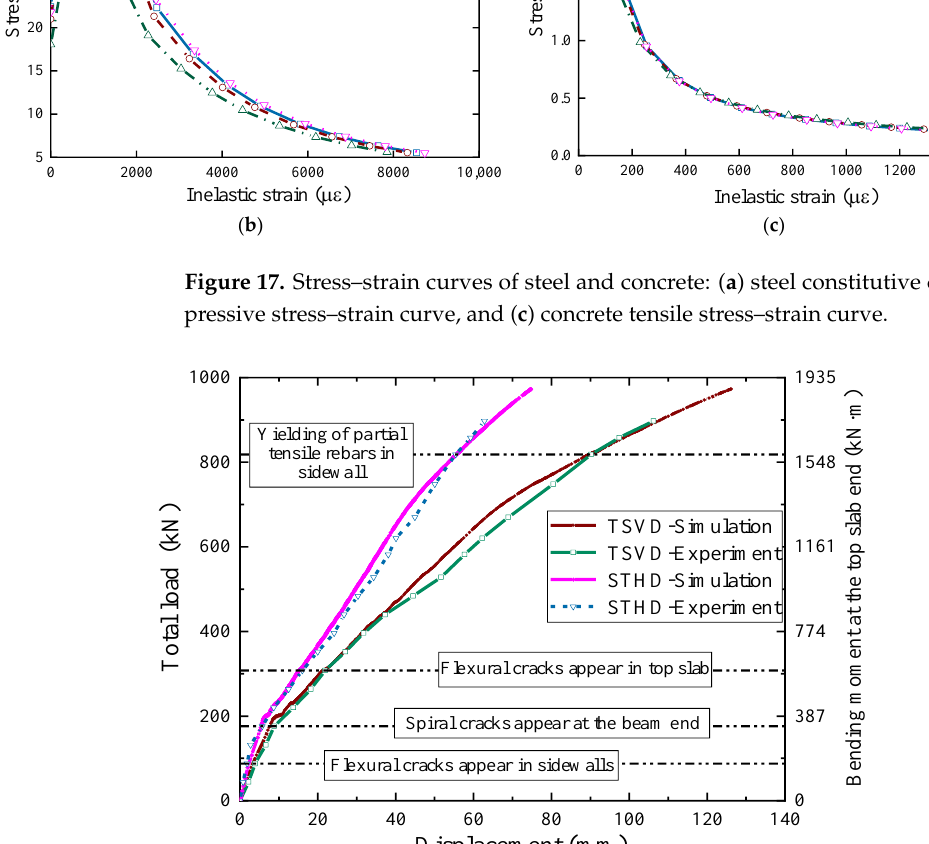
Figure 19. Maximum principal inelastic strain patterns from FE analysis. 4.3. Parametric Study A parametric study was conducted using the validated FE model to further investi- gate the effects of the entrance frame with different configurations on the development of cracks around the opening. The parameters were the steel ratio of the SRC frame and cross-sectional height of the column and beam. Table 3 summarizes the details of all cases in this parametric study. For convenience, these cases are denoted as E-X. Case E-1 em- ployed a validated FE model with a configuration similar to that of the test specimen, which could be treated as the baseline configuration for the other cases. Compared to E- 1, the steel ratio of the SRC beam in E-2 was zero, and that of the SRC column in E-3 was zero as well. Both cases were designed to investigate the effects of the steel ratio of the entrance frame. In addition, the cross-sectional height of the SRC beam increased to 800 mm in Case E-4, and the cross-sectional width of the SRC column increased to 550 mm in Case E-5. An increase in the cross-sectional heights of the SRC beam and column directly improved the bearing capacity and out-of-plane stiffness. For Cases E-4 and E-5, although